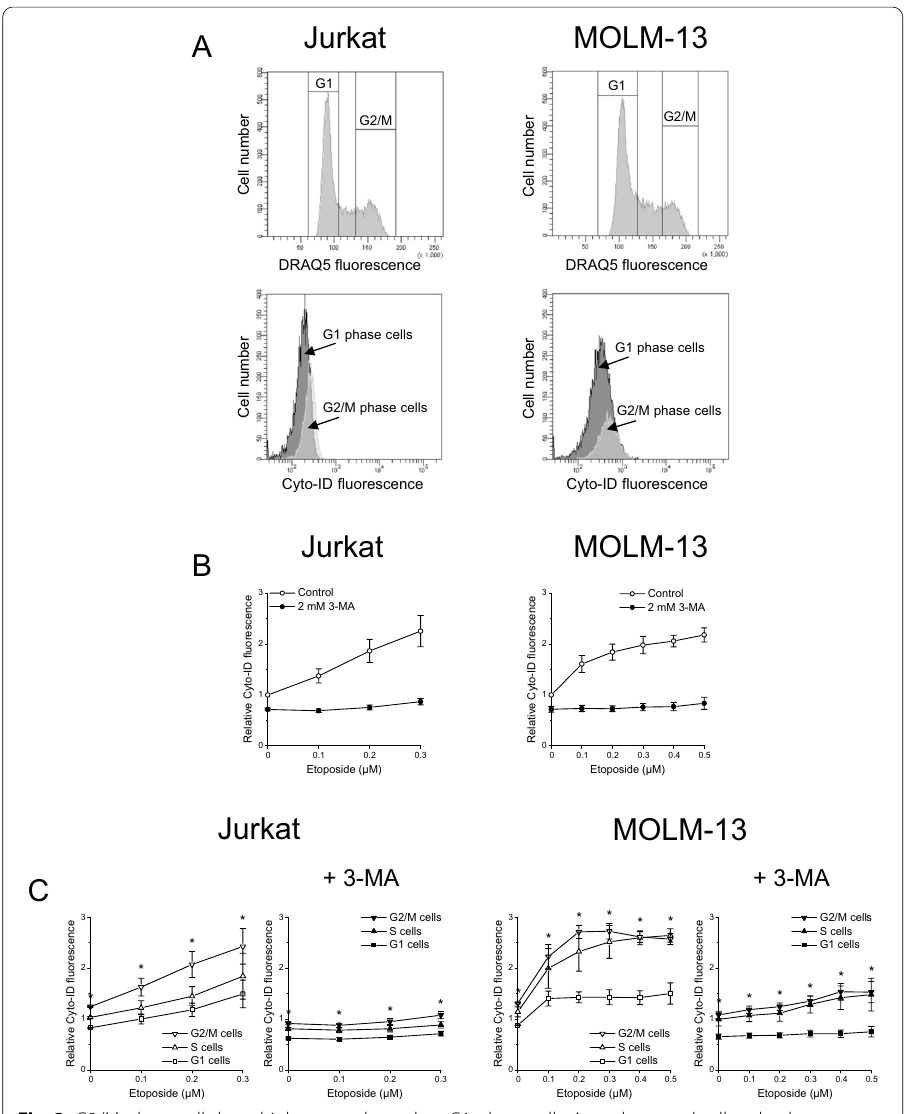
Fig. 2 G2/M‑phase cells have higher autophagy than G1‑phase cells. Autophagy and cell cycle phases were determined by flow‑cytometric analysis of Cyto‑ID DRAQ5 double‑stained cells. A Representative + histograms of untreated cells. B, C Cells were exposed to etoposide with or without 3‑MA for 24 h (Jurkat) or 48 h (MOLM‑13). Cyto‑ID fluorescence intensities were normalized to the mean Cyto‑ID fluorescence intensities of untreated cells. Mean SEM of three independent measurements is shown (G1 cells versus ± G2/M cells: * P <